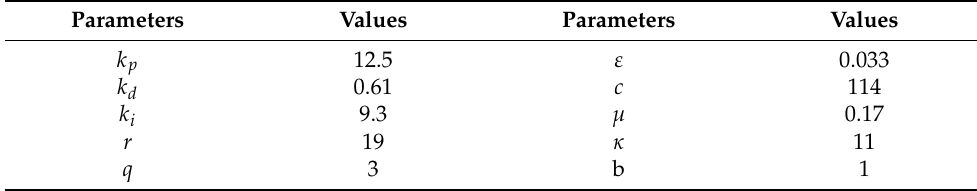
Table 2. BFATSM control parameter